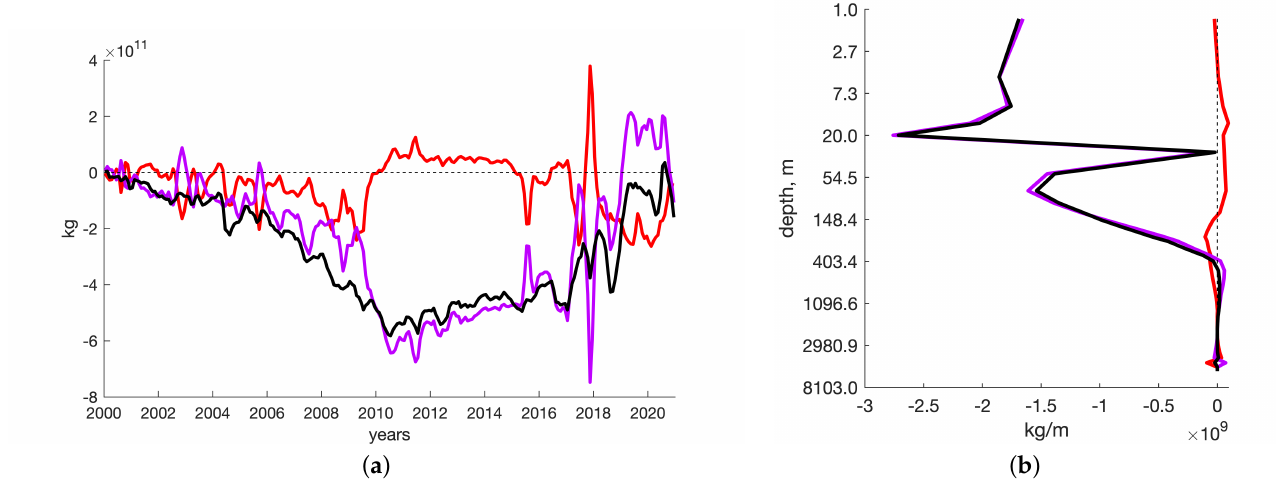
Figure 17. The difference in mass (black curves), heat (red curves), and salt (magenta curves) content in terms of the increment in the mass of water (kg) in the Arctic (above 65 N): ( a ) time series of the whole content, ( b ) vertical distribution averaged over time in terms of incremental values in numerical experiment C2 to experiment B.